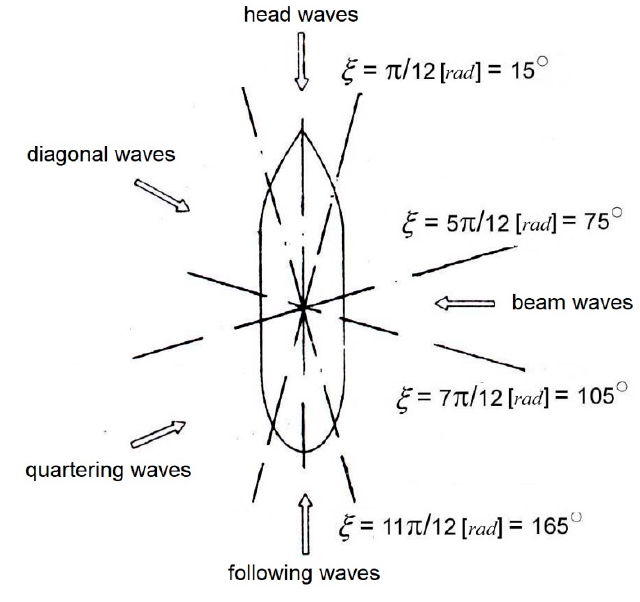
Figure 2. Definition of the wave angle.